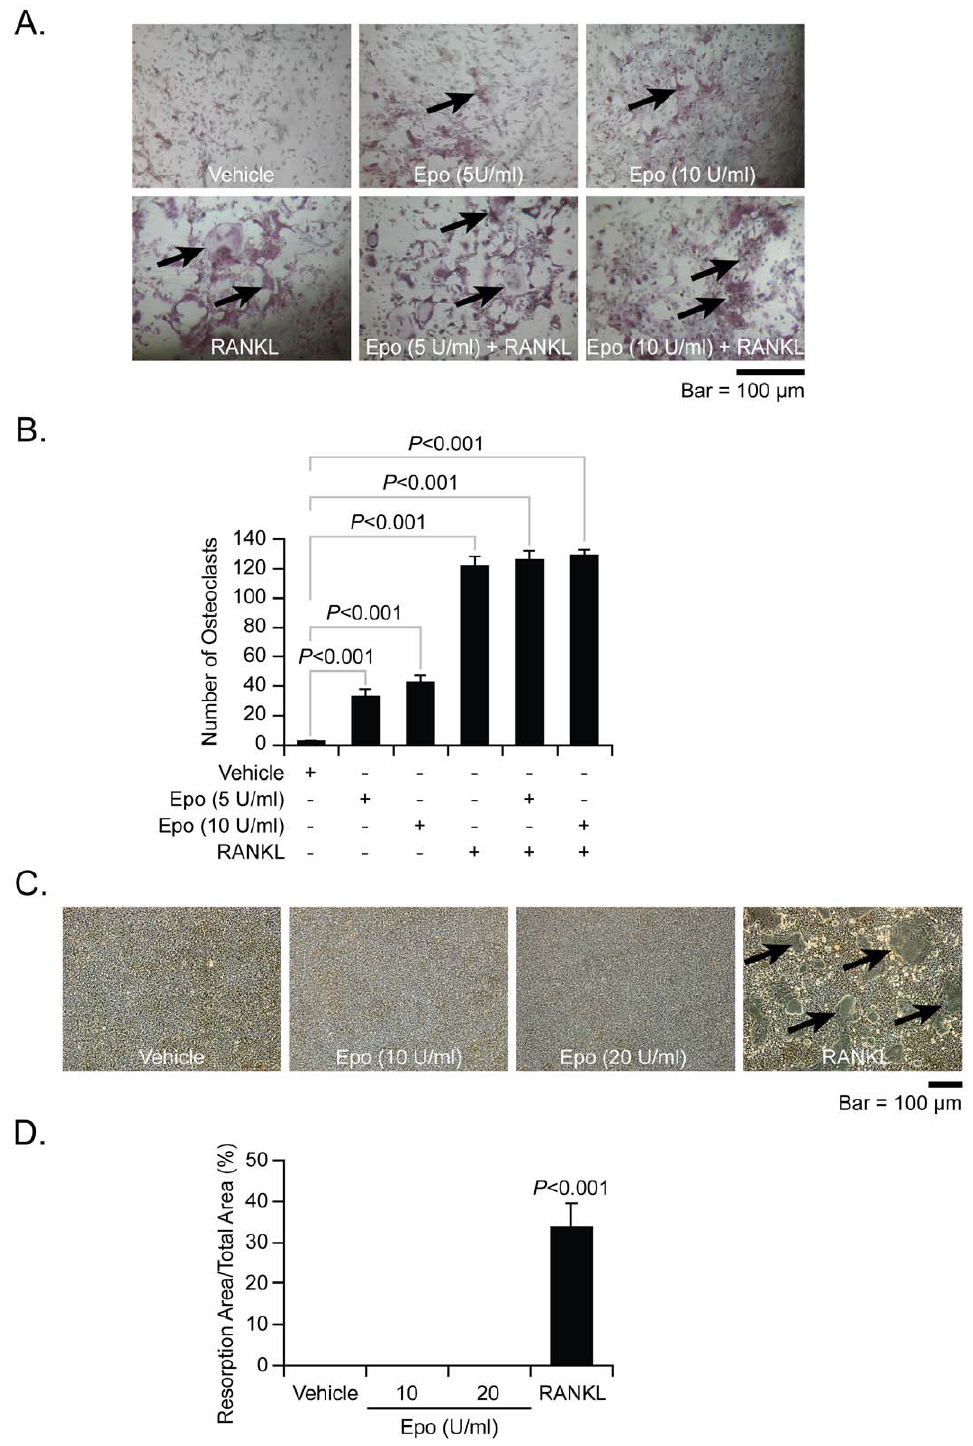
Figure 3. Epo supports osteoclastogenesis but not bone resorbing activities. To evaluate if Epo regulates osteoclastogenesis, marrow mononuclear cells ( MMCs ) (1 6 10 5 cells/well) were treated with rhEpo (5–10 U/ml) and/or RANKL (50 ng/ml (as a postitive control) in 96-well plates. At 5 days, staining for TRAP was performed. ( A ) Representative light-microscopic images or cells expressing TRAP in mixed MMC culture. Original magnification at 40 6 . Bar=100 microns. ( B ) The numbers of TRAP-positive cells from quantified in (A). Data from a representative of three experiments are presented as the mean 6 standard error of the mean. Significant differences from vehicle treatment groups. To examine if Epo stimulate the function of osteoclasts, MMCs (5 6 10 5 cells/well) were seeded on the resorbable artificial bone film-coated disks and incubated with rhEpo (10–20 U/ml), or rhRANKL (50 ng/ml). ( C ) Representative micrographs demonstrating bone resorption and resorption area quantified in ( D ). Original magnification at 20 6 . Bar=100 microns. Data from a representative of three experiments are presented as the mean 6 standard error of the mean. Significant differences from vehicle treatment groups. doi:10.1371/journal.pone.0010853.g003 PLoS ONE |